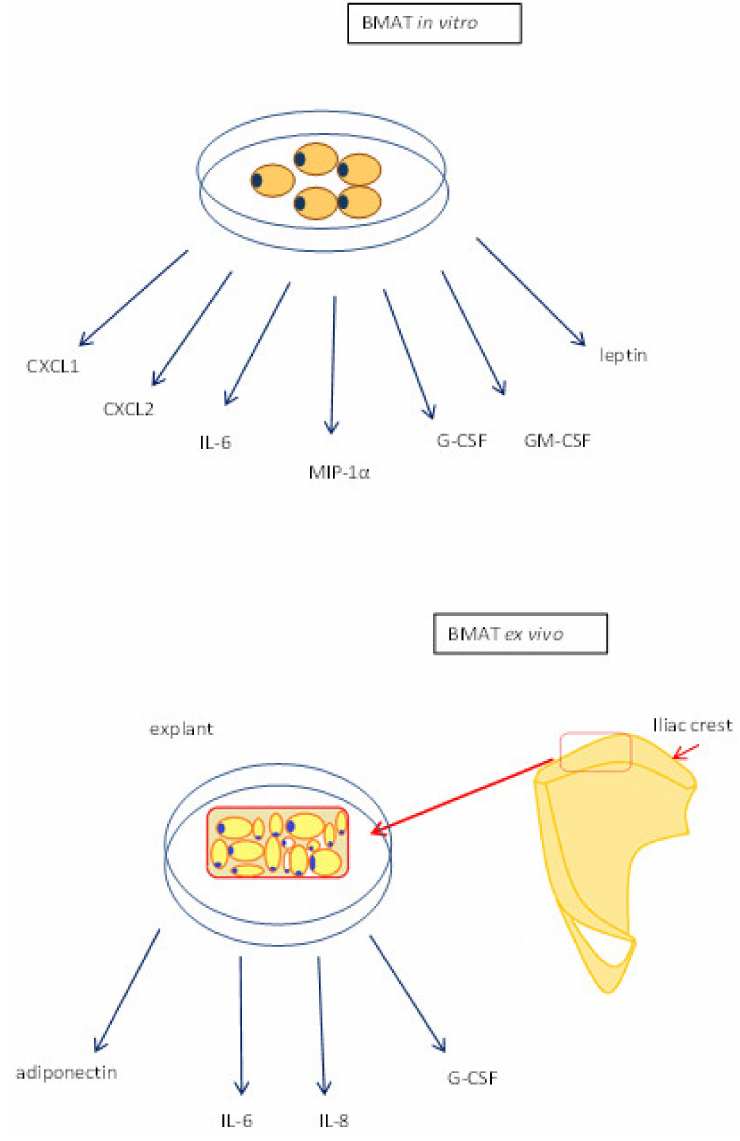
Figure 1. BMAT secretion of cytokines in different experimental protocols (extracted cells or whole tissue explants—without separation of single adipocytes). CXCL1—chemokine (C-X-C motif) ligand 1; CXCL2—chemokine (C-X-C motif) ligand 2; G-CSF—granulocyte colony-stimulating factor;